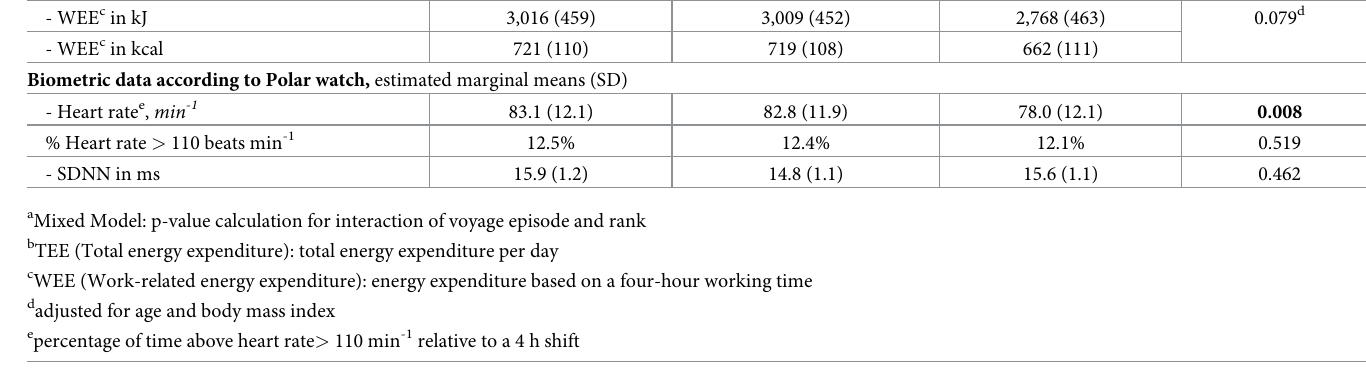
Table 4. Objective strain parameters depending on the voyage episode. Voyage episode Port stay River passage Sea passage p a